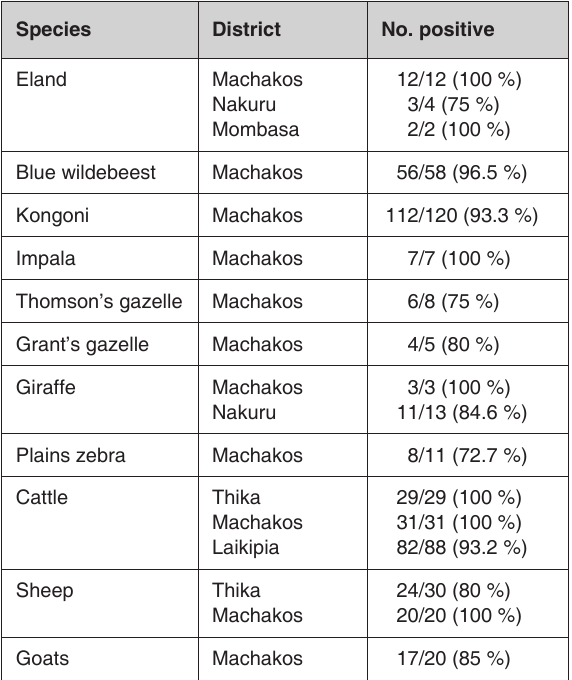
TABLE 1 Seroprevalence of antibodies to Anaplasma spp. in various species at the wildlife/livestock interface